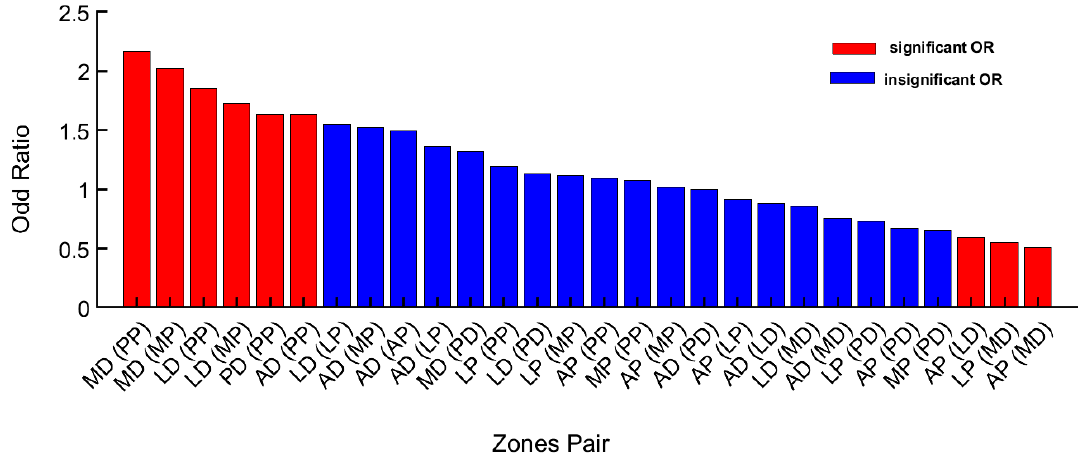
Figure 5. The 28 odds ratios sorted and colour-coded for 28 pairwise comparisons.